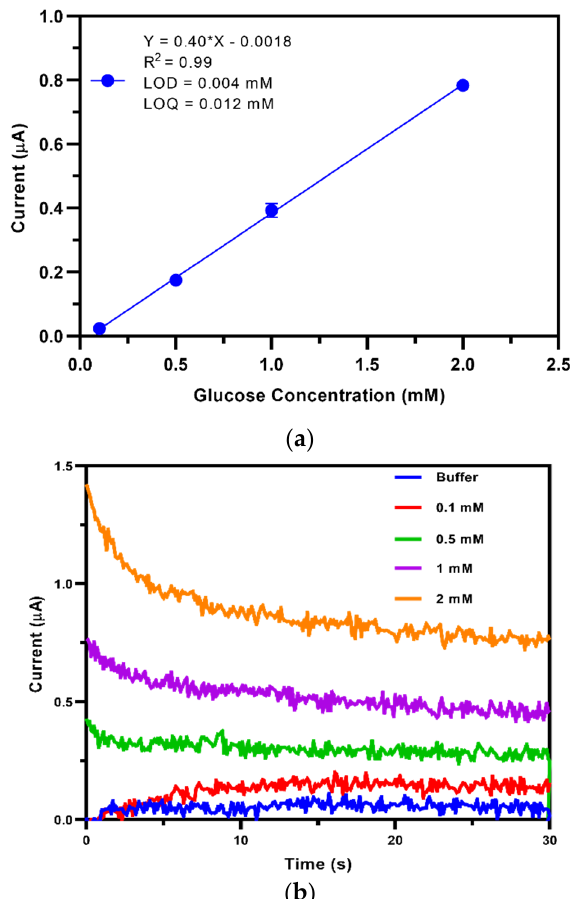
Figure 4. ( A ) Raw data sets of chronoamperometry measurements with the TEMPO-CNC glucose sensor in phosphate buffer containing 0.1–2 mM glucose. ( B ) Calibration curve of the TEMPO-CNC glucose sensor in 0.1–2 mM glucose in phosphate buffer. The linear range (up to 2 mM) was smaller than the entire dynamic range. n = 3; plotted are the mean ± standard deviation and the linear fit from 0.1 to 2 mM.